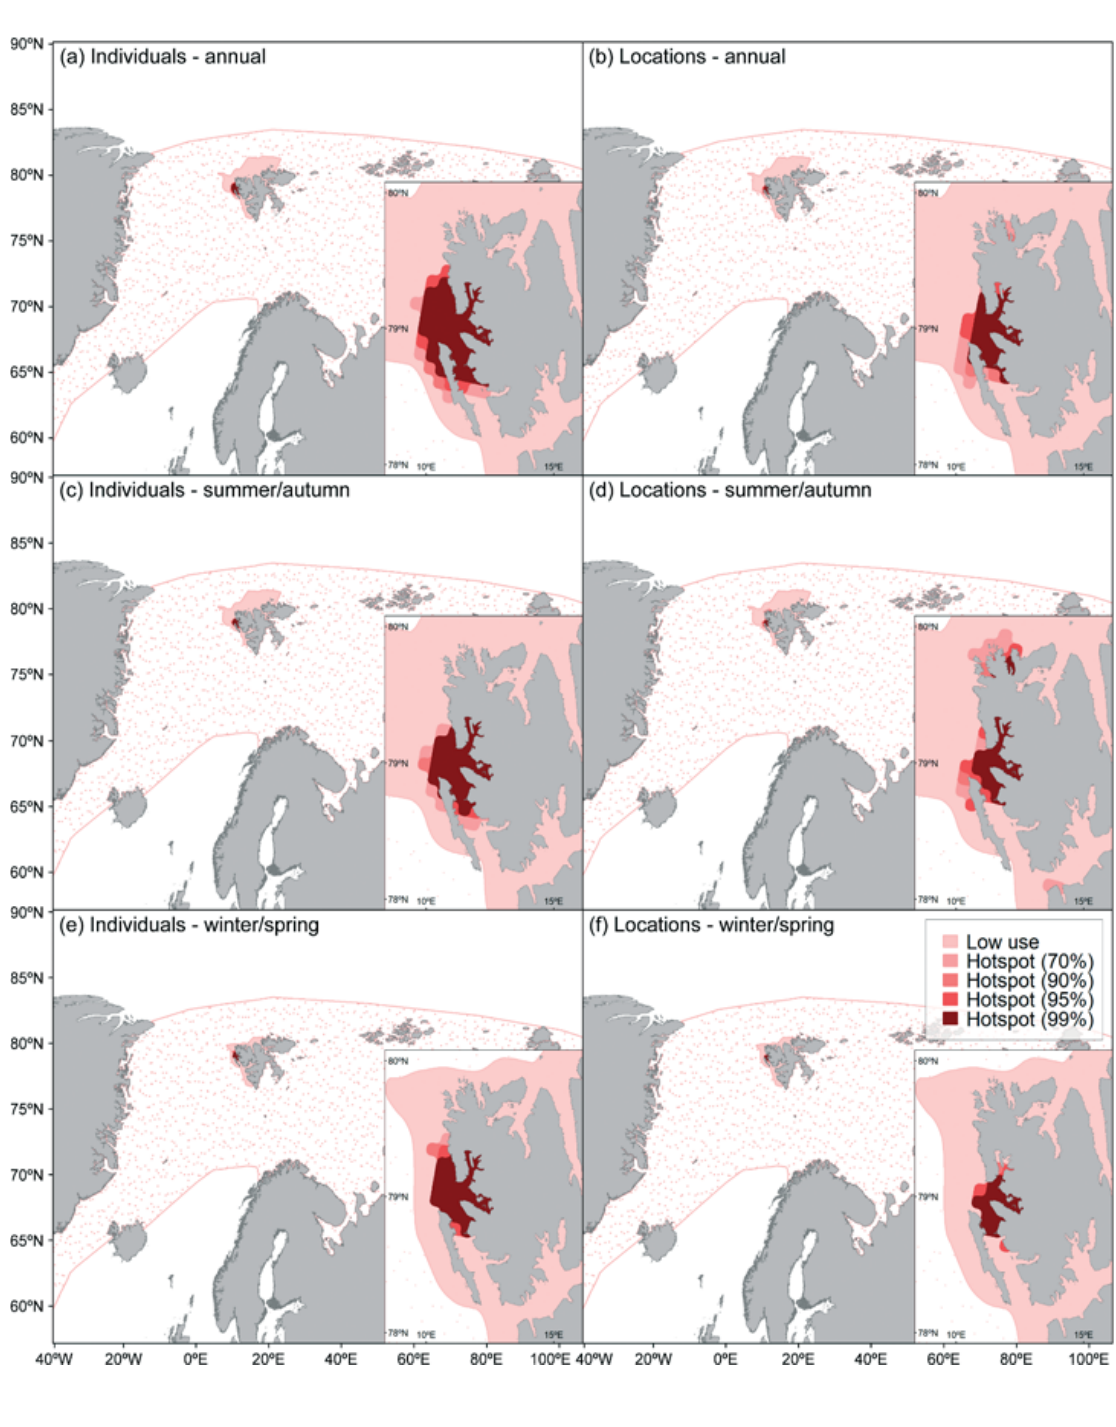
Figure 3. Getis−Ord Gi* (a,c,e) individual hotspots and (b,d,f) location hotspots for 20 bearded seals tagged in Svalbard over (a, b) the entire year, (c, d) during the summer/autumn and (e, f) during the winter/spring. Inset maps show hotspots in north-western Svalbard (Hamilton et al.,